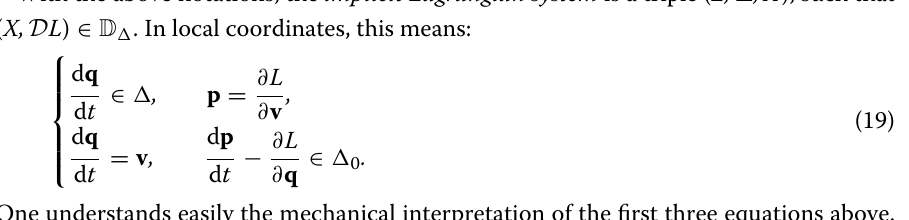
where Leg ( (cid:5) ) is the image of (cid:5) by the Legendre transform. X should be viewed as a vector field on R d × V ∗ , with the momenta parametrized by the Legendre transform of the velocities compatible with the